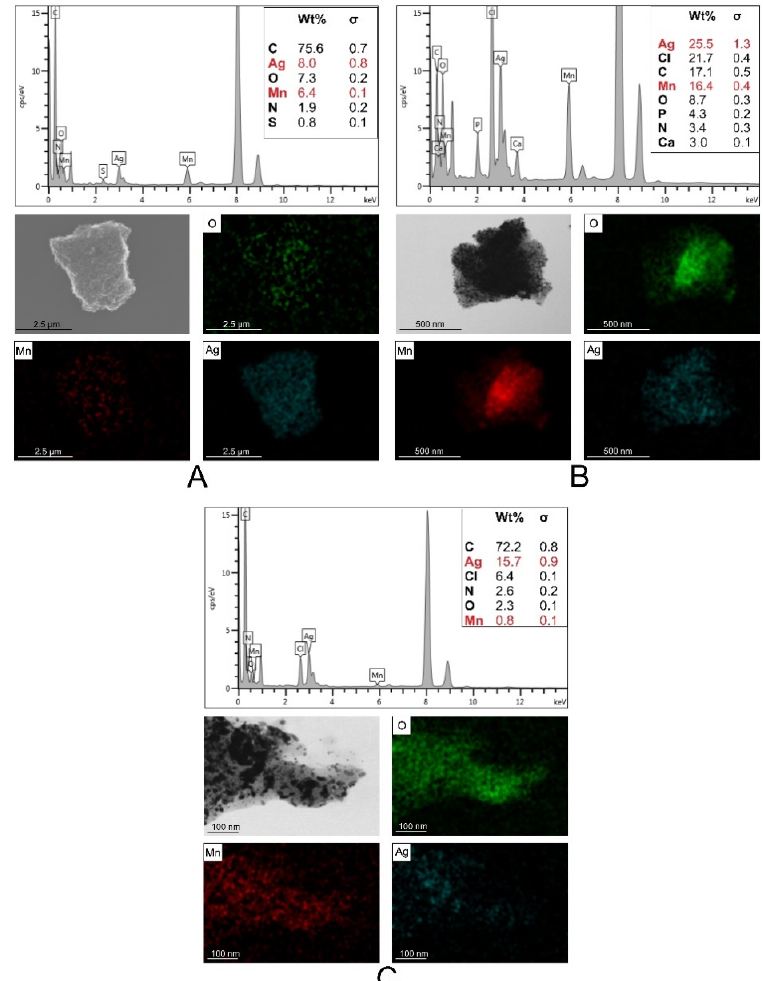
Figure 3. EDX spectra showing the elemental distribution in the green synthesized nanoparticles; A : CmNPs, B : VmNPs, C : MNPs.